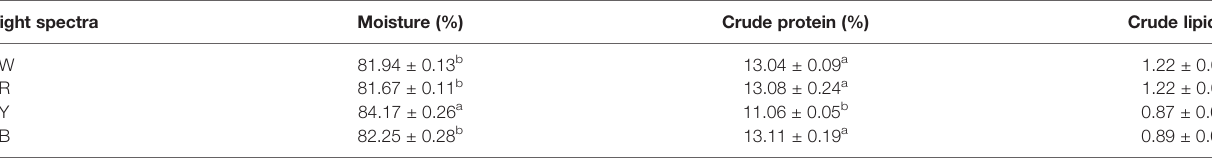
TABLE 2 | Effects of different light spectra on the composition of GIFT tilapia juveniles. Light spectra